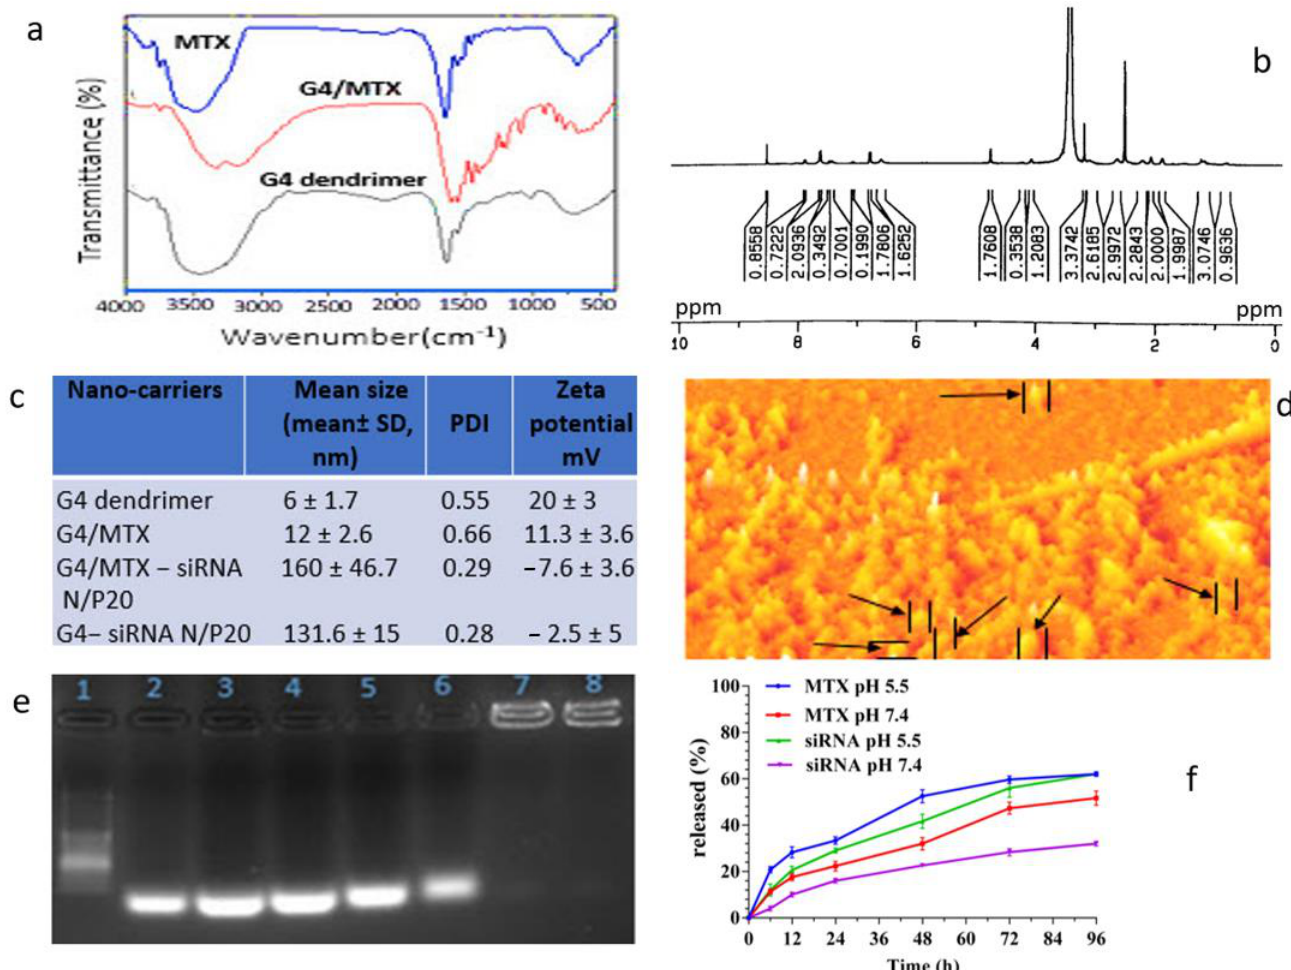
Figure 1. Physiochemical characterization of G4 dendrimer-based nanocarriers. ( a ) FTIR spectra of G4 dendrimer, G4/MTX and MTX; ( b ) NMR spectra of G4/MTX; ( c ) the hydrodynamic particle size, PDI and zeta potential values of dendrimer based nanosystems that were analyzed using DLS; ( d ) atomic force microscopic (AFM) image of G4/MTX-siRNA nanocomplex at N/P 20. ( e ) Representative image of gel retardation assay for G4/MTX-siRNA at different N/P ratios. ( f ) In vitro MTX and siRNA release profiles of G4/MTX-siRNA at 37 ◦ C in PBS with pH 7.4 and pH 5.5 during 96 h